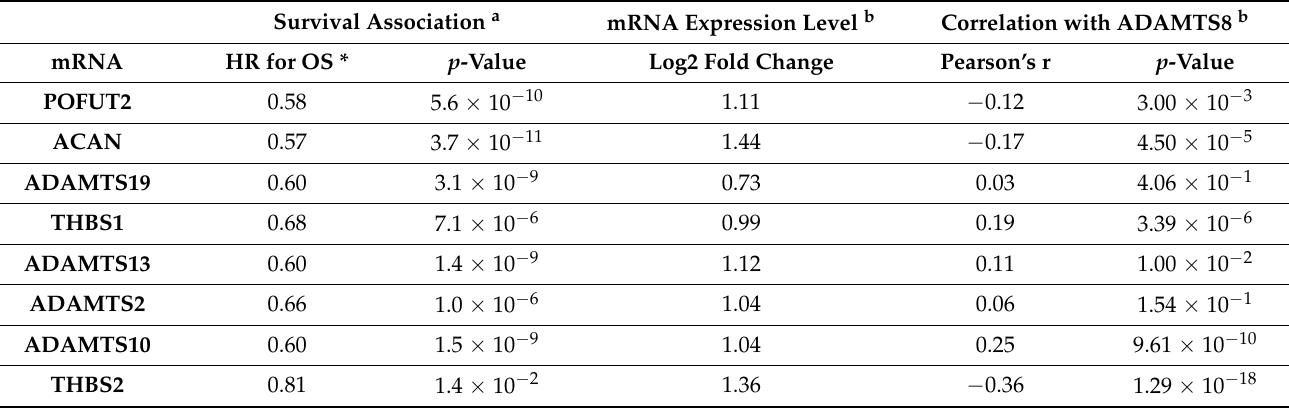
Table 2. The potential interactive molecules of